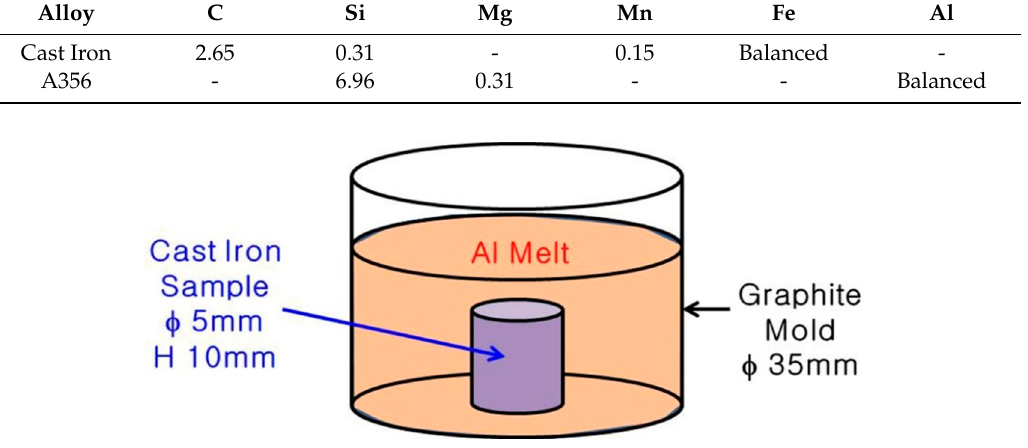
Figure 1. Schematic diagram of cast iron / liquid aluminum interaction experiment.